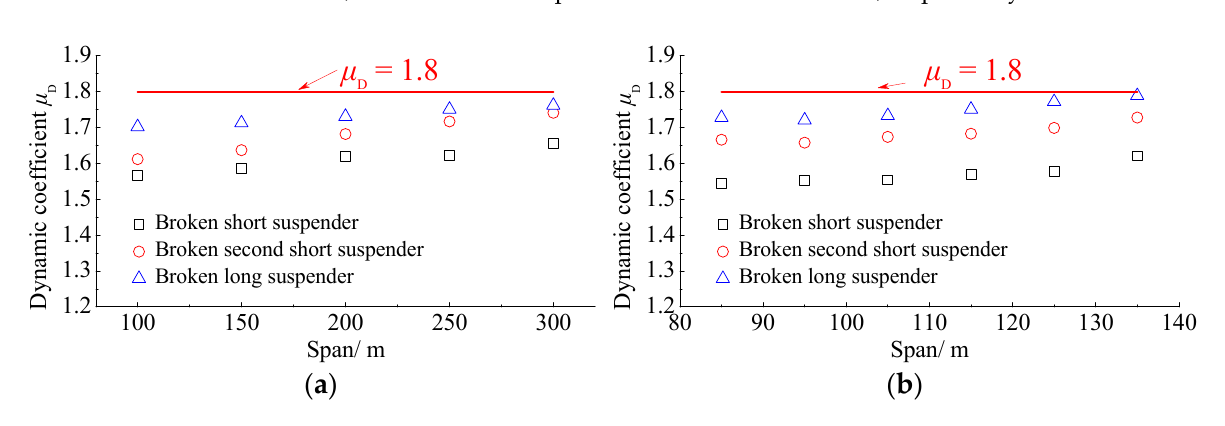
Figure 26. The relationship between the dynamic coefficient and the span length for the longitudinal beam: ( a ) half ‐ through CFST standard arch bridges; ( b ) through CFST standard arch bridges.